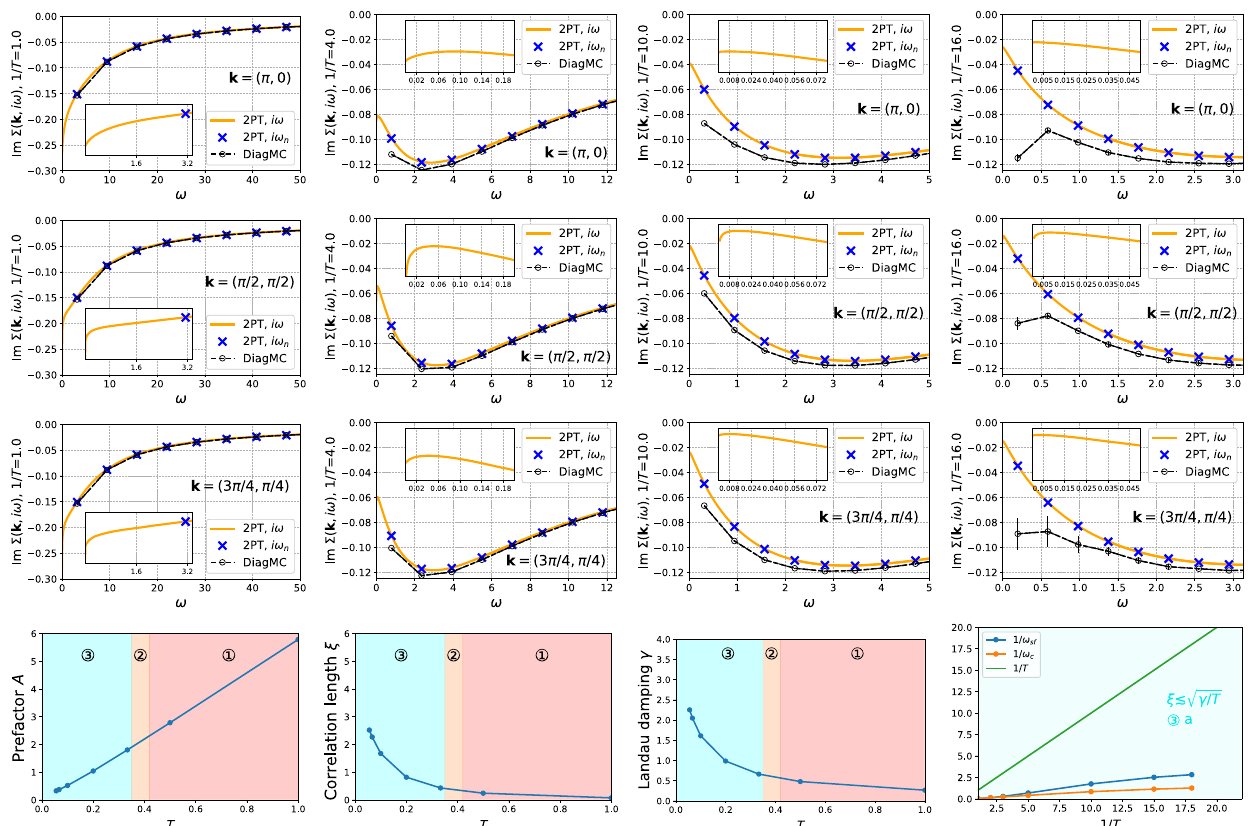
FIG. 31. Comparison of the imaginary part of the self-energy as a function of imaginary frequency for the antinode and node (first and second rows, respectively) obtained by 2PT (orange solid lines; blue crosses mark the Matsubara frequencies) to the DiagMC benchmark (black open circles, dashed lines) for various temperatures ( 1 =T ¼ 1 , 4, 10, and 16 from left to right). The insets show a zoom of the lowest-frequency data (the interval range of the y axis is constant for all k -points shown in order to ensure comparability). Third row: results for k ¼ ð 3 π = 4 ; π = 4 Þ . Lowest row: Ornstein-Zernike parameters (for the bubble) and energy scales for 2PT (obtained from a Matsubara fit) as functions of (inverse)